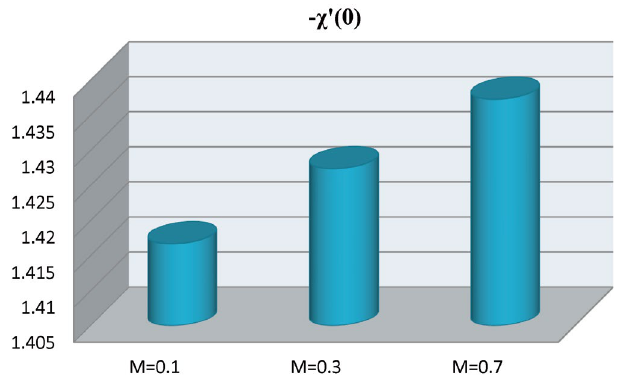
Figure 9. Local microorganism’s density number versus magnetic